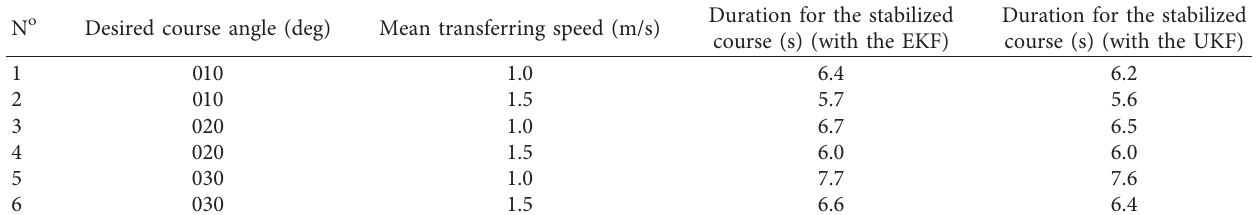
Table 4: Experimental scenarios and obtained test data for the course tracking of the M-AUV. N o Desired course angle (deg) Mean transferring speed (m/s)